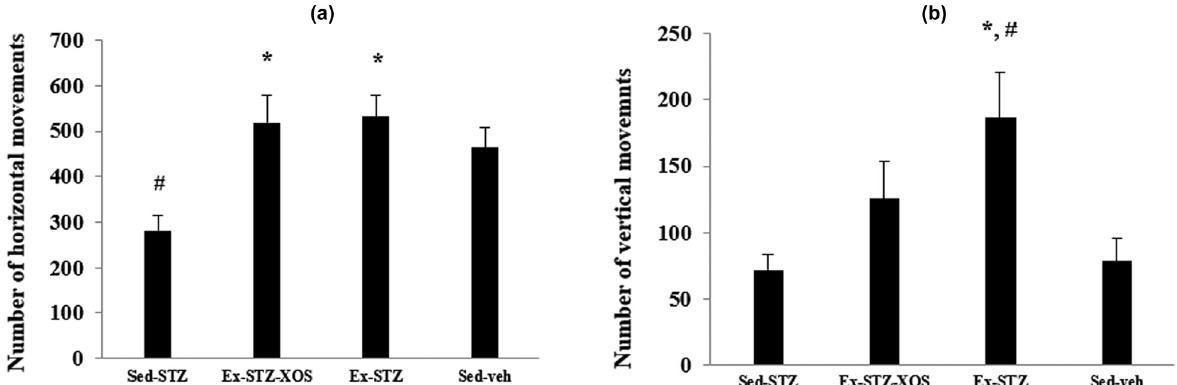
Figure 2: E ff ect of XOS and/or aerobic training on the results from the activity cage test. ( a ) Horizontal activity; ( b ) Vertical activity. * Signi fi cant di ff erences in comparison to Sed - STZ. # Signi fi cant di ff erences in comparison to Sed -